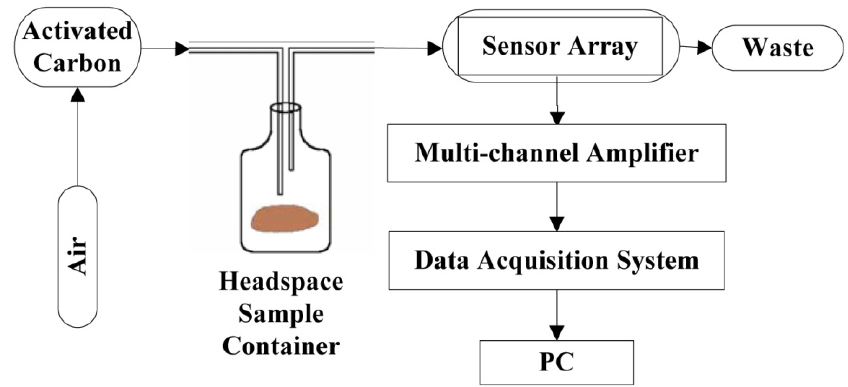
Figure 1. Schematic diagram of the electronic nose